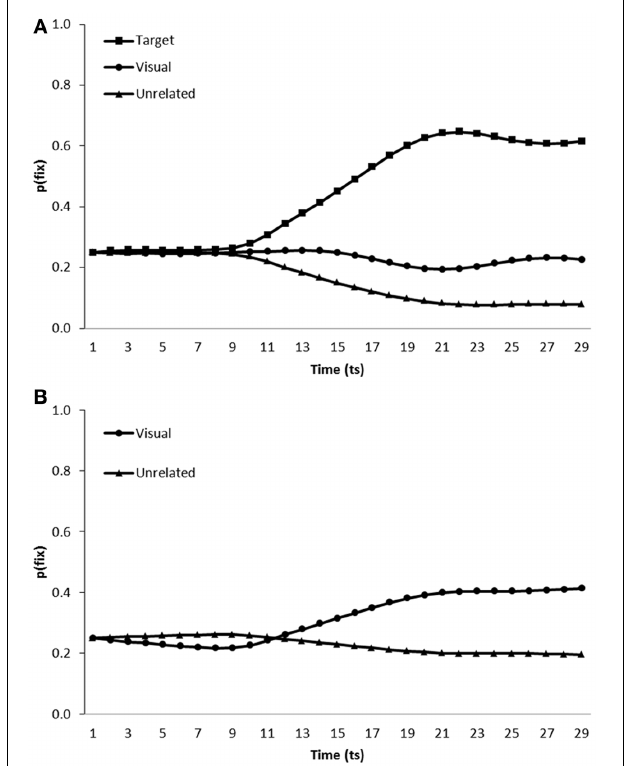
FIGURE 6 | Proportion of fixations [p(fix)] directed toward items within scenes containing (A) a target, visual competitor and two unrelated distractors (B) a visual competitor and three unrelated distractors; by the model trained in a noisy learning environment.